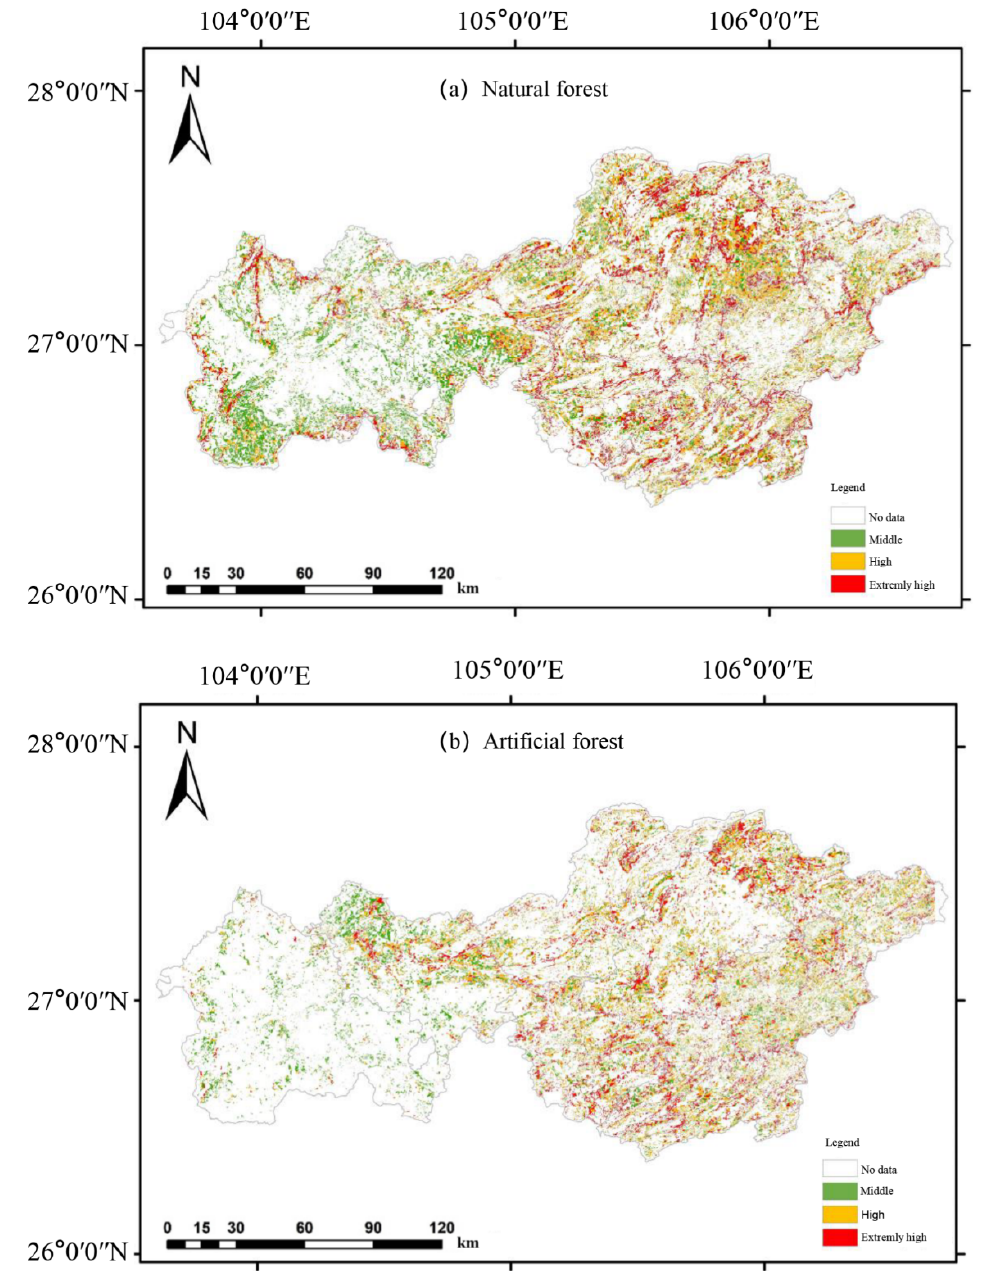
Figure 5. Spatial distribution of forest origin and landslide susceptibility in Bijie City.